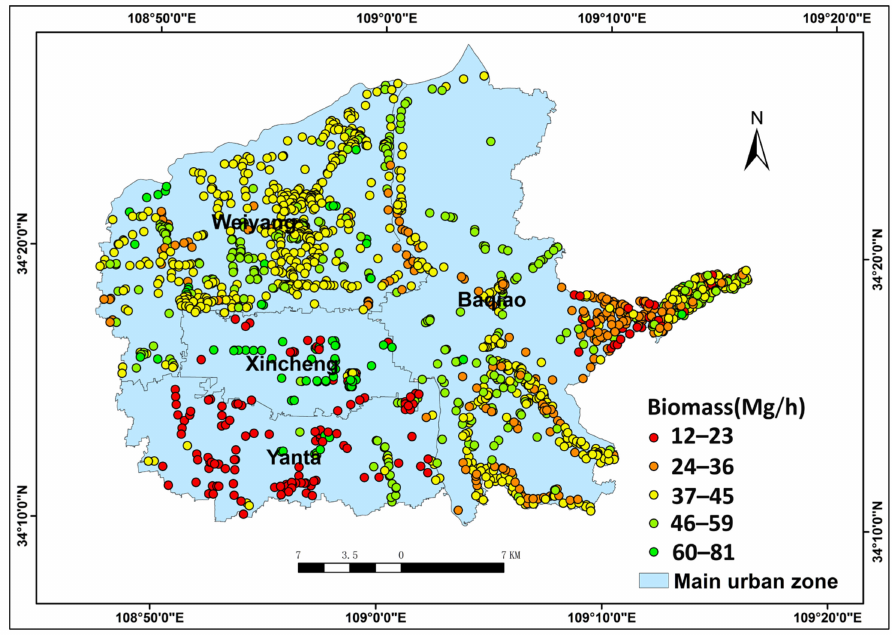
Figure 2. Distribution of biomass grades of 1480 plots.